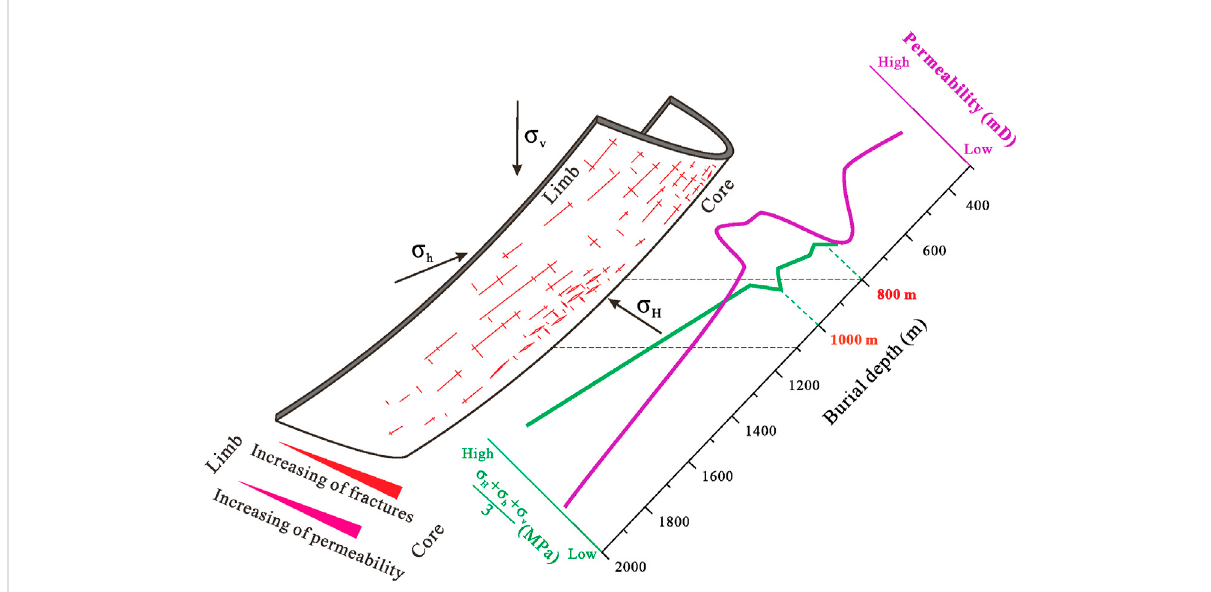
FIGURE 15 Permeability variation model showing the combined effects of in-situ stressesand coal structures on permeability in theFukang area, southern Junggar